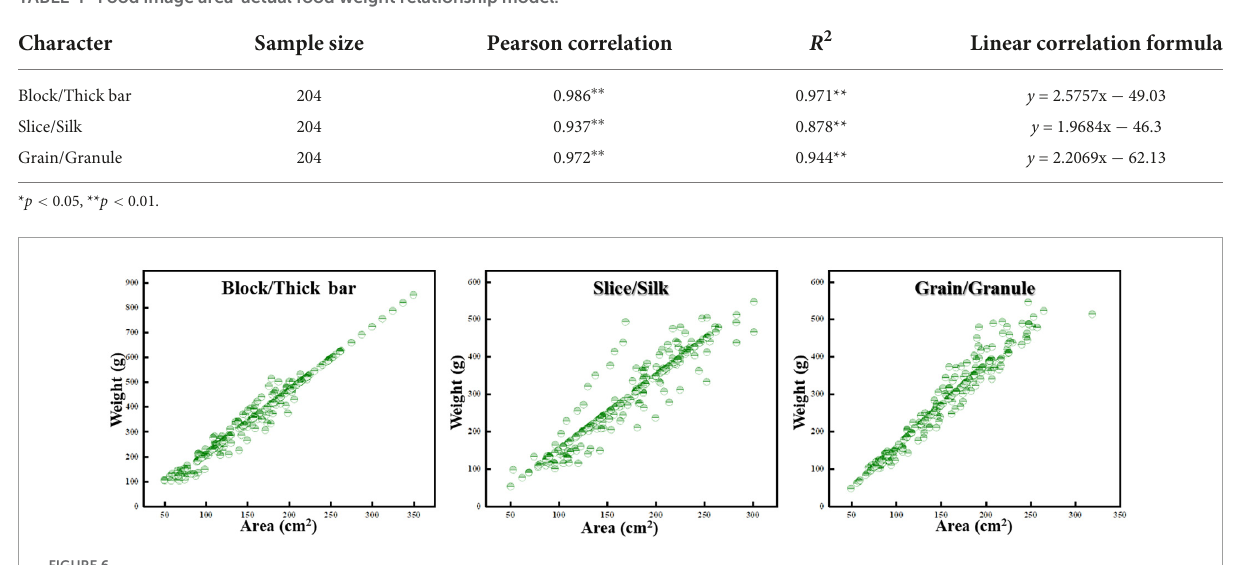
FIGURE6 Scatter plot of food image area-actual food weight